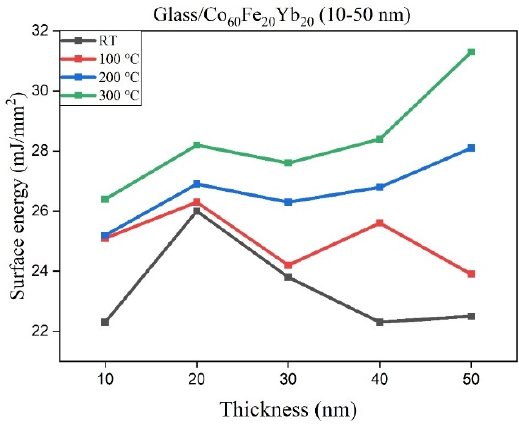
Figure 7. Surface energy of CoFeYb thin films.